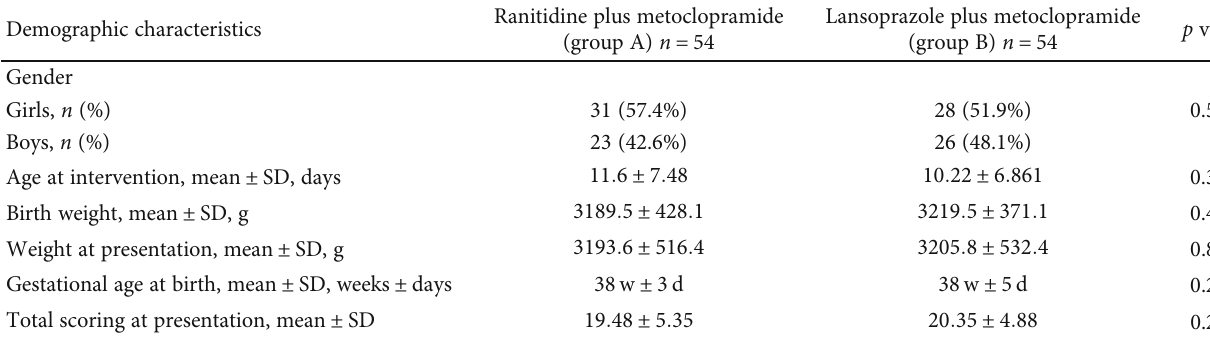
Figure 1: CONSORT fl ow Table 2: Demographic characteristics in two intervention groups.